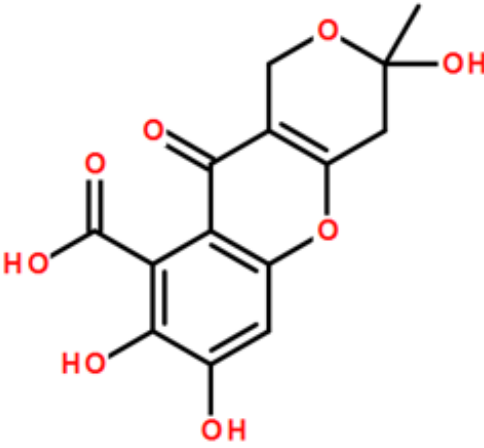
Figure 7. Chemical structure of FA.